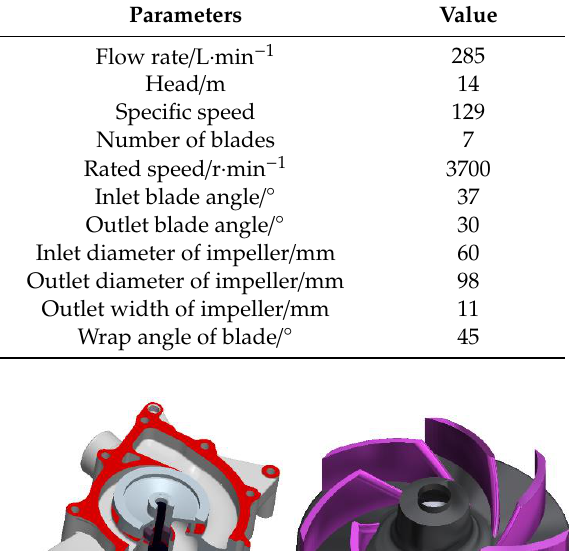
Table 1. Design and structure parameters of engine cooling water pump (ECWP).